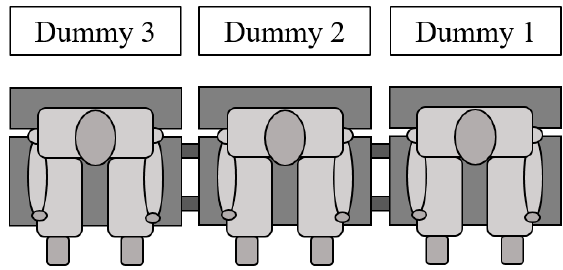
Figure 11. Ν umbering of Anthropomorphic Test Devices. Figure 11. Numbering of Anthropomorphic Test